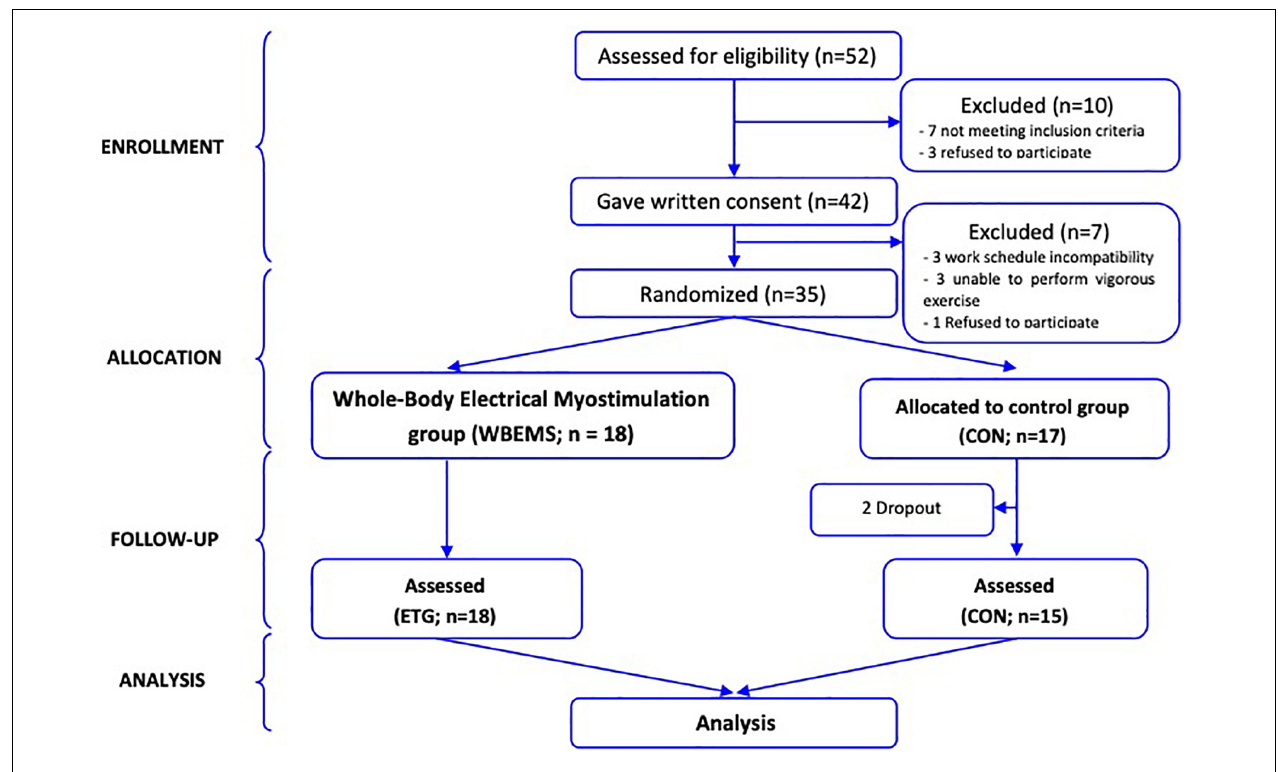
FIGURE 1 | Flow of participants through the trial.